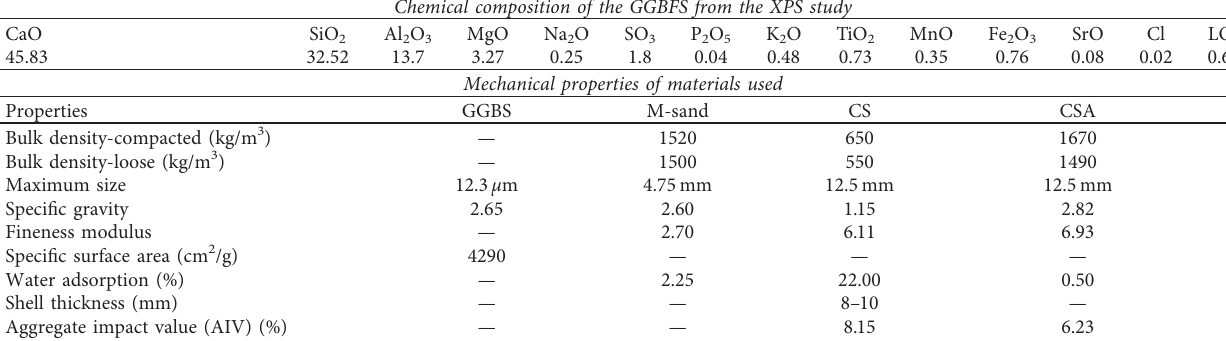
Table 1: Chemical composition and mechanical properties of the materials used.